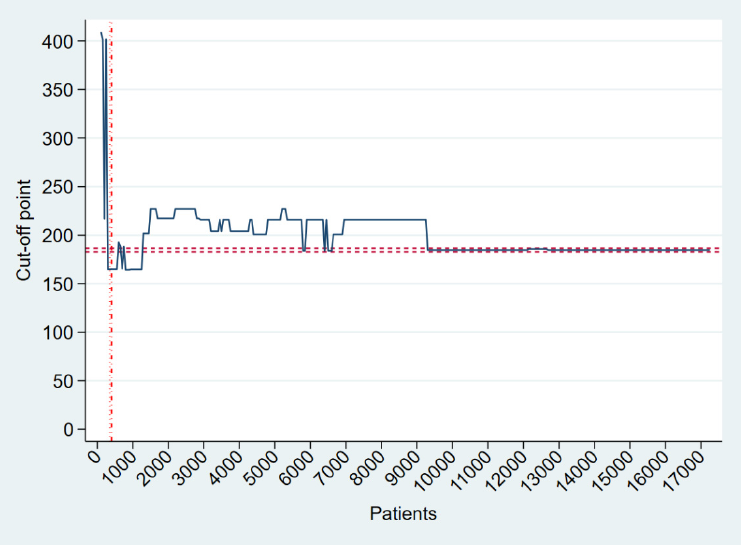
Figure 4. Line plot of chosen cut-off points for the real-life example. Cut-off points were determined for n = 101, 151, 201, …, 17,251 (dark blue lines). Horizontal, dashed lines indicate a maximum of 1% deviation from the empirical optimal cut-off point (184.7; target area). Vertical, dotted lines and vertical dashed-dotted lines represent the point at which the heuristic and path-based algorithm stops when using increments of n = 50 and n = 100 subjects, respectively.